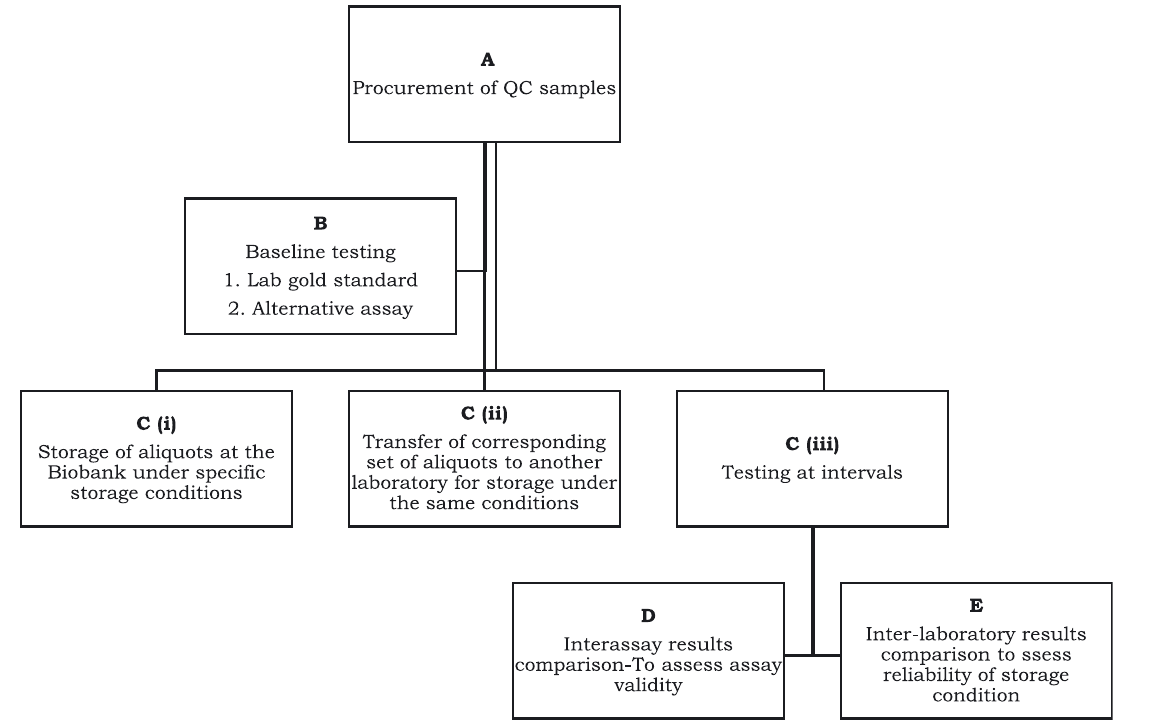
Figure 2: Process flowchart for optimising storage conditions for biospecimens at the NHLS